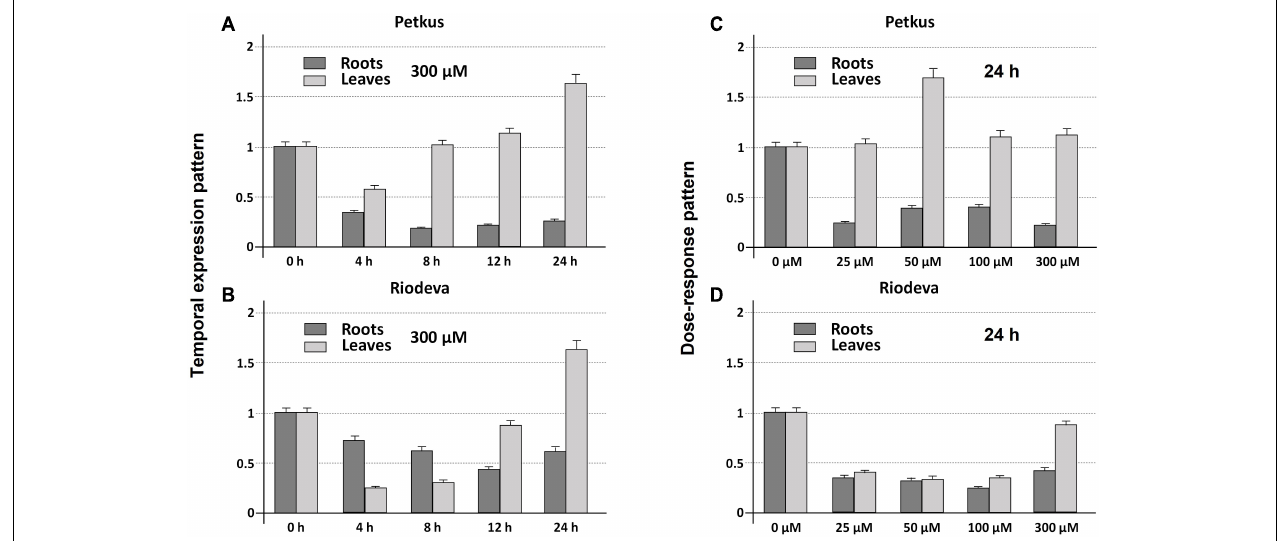
FIGURE 4 | Temporal expression (A,B) and dose-response patterns (C,D) (qRT-PCR) of root apices and leaf cDNA transcripts of ScCS4 gene from the Petkus (tolerant cultivar) (A,C) and Riodeva (sensitive inbred line) (B,D) in the absence of Al (0 h) or with 300 µ M of AlK (SO4) 2 at 4, 8, 12, and 24 h (temporal expression patterns) or with Al at 0, 25, 50, 100, and 300 µ M for 24 h (dose–response patterns). Change is expressed as the relative difference in expression without Al (0 h or 0 µ M) compared with each time point. The expression level of 18S rRNA was used as a loading control. Error bars represent standard deviations (SDs). All data are the means of three independent biological and technical replicates. Y-axis: Change (fold difference) at each time point is expressed as the relative difference in expression compared with the case selected as reference (relative expression level 1).